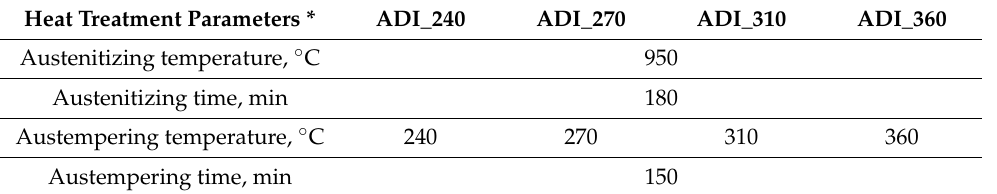
Table 2. The process parameters used for manufacture of the tested ADI. Heat Treatment Parameters * ADI_240 ADI_270 ADI_310 ADI_360 Austenitizing temperature, ◦ C 950 Austenitizing time, min 180 240